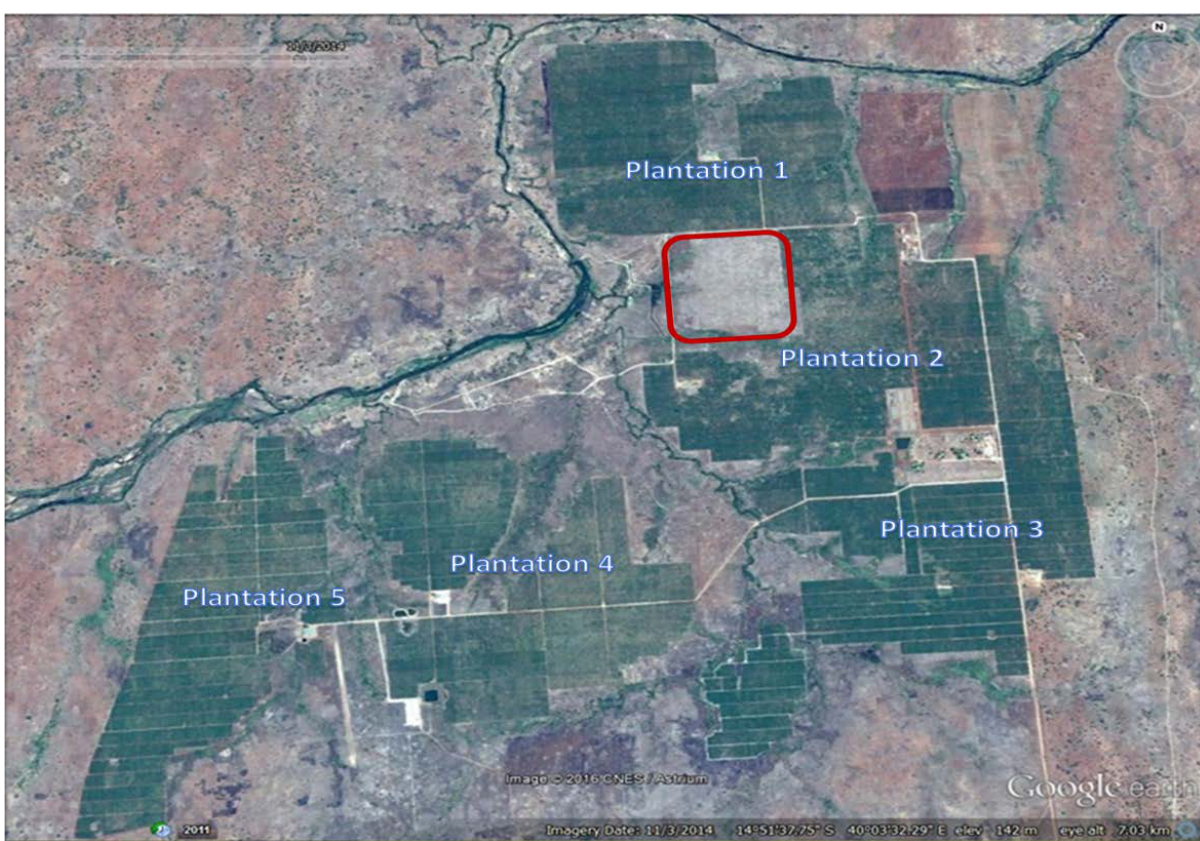
Metocheria farm consisted of five plantations. More than 50 hectares of banana was killed after the discovery of Fusarium wilt in 2013 (inside red square), and the area has been replanted with Formosana somaclones from Taiwan since 2016.